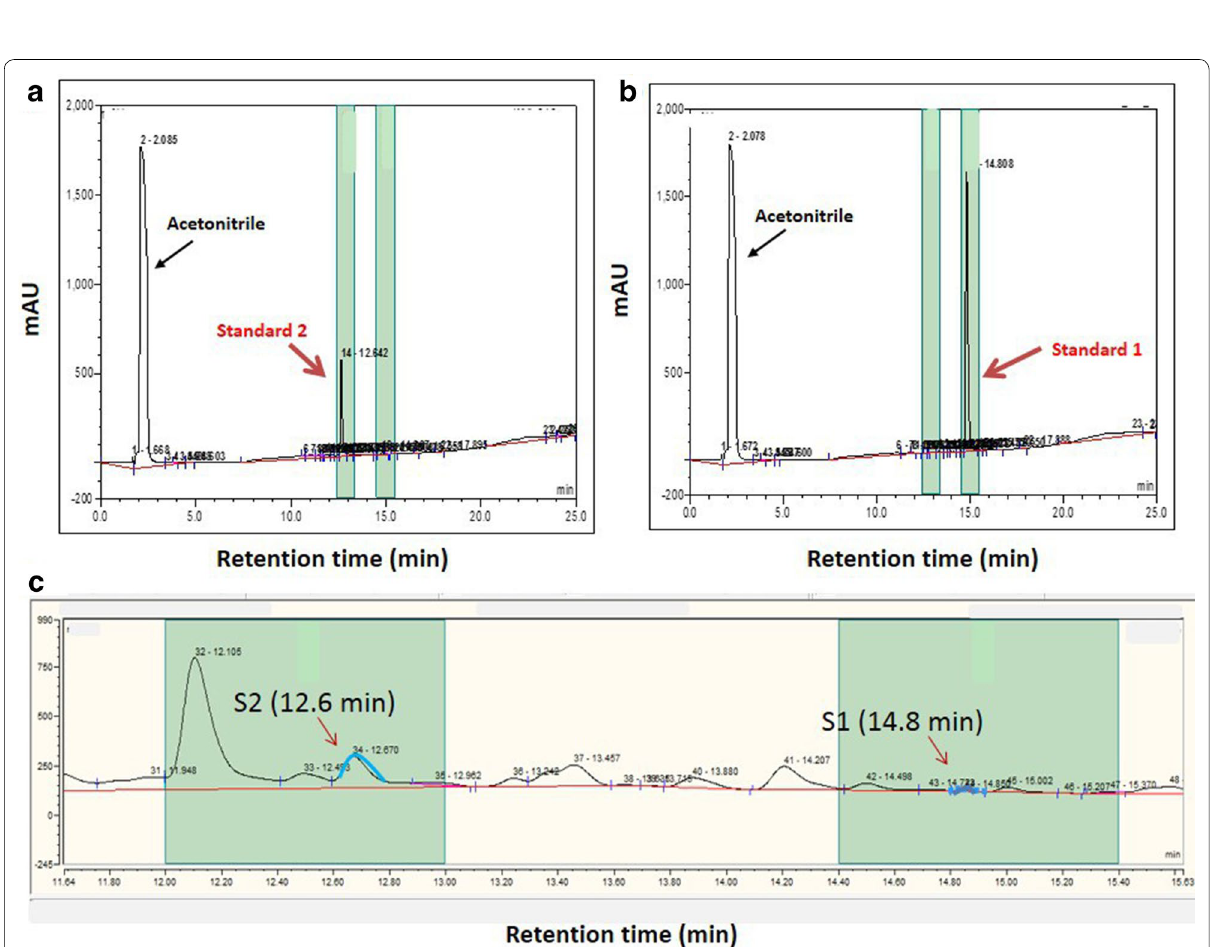
Fig. 3 Chromatogram of standards and collected fractions associated to the standards retention times during gradient HPLC. a Standard 2 mol- ecule (200 μg ml − 1 ). b Standard 1 molecule (400 μg ml − 1 ). c The zoomed fraction areas of one HPLC run related to extracted supernatant. Collection of the samples was performed from two fractions (presented in green time windows). First fraction was collected between 11.90 min and 12.90 min to cover the specific retention time of standard 2 (12.6 min). Second fraction was collected between 14.40 and 15.40 min according to the retention time of standard 1 (14.8 min). The red arrows presented in image b (S1 and S2) point at the interested peaks in the fractioning time which are repre- senting the retention time of standard 1 and standard